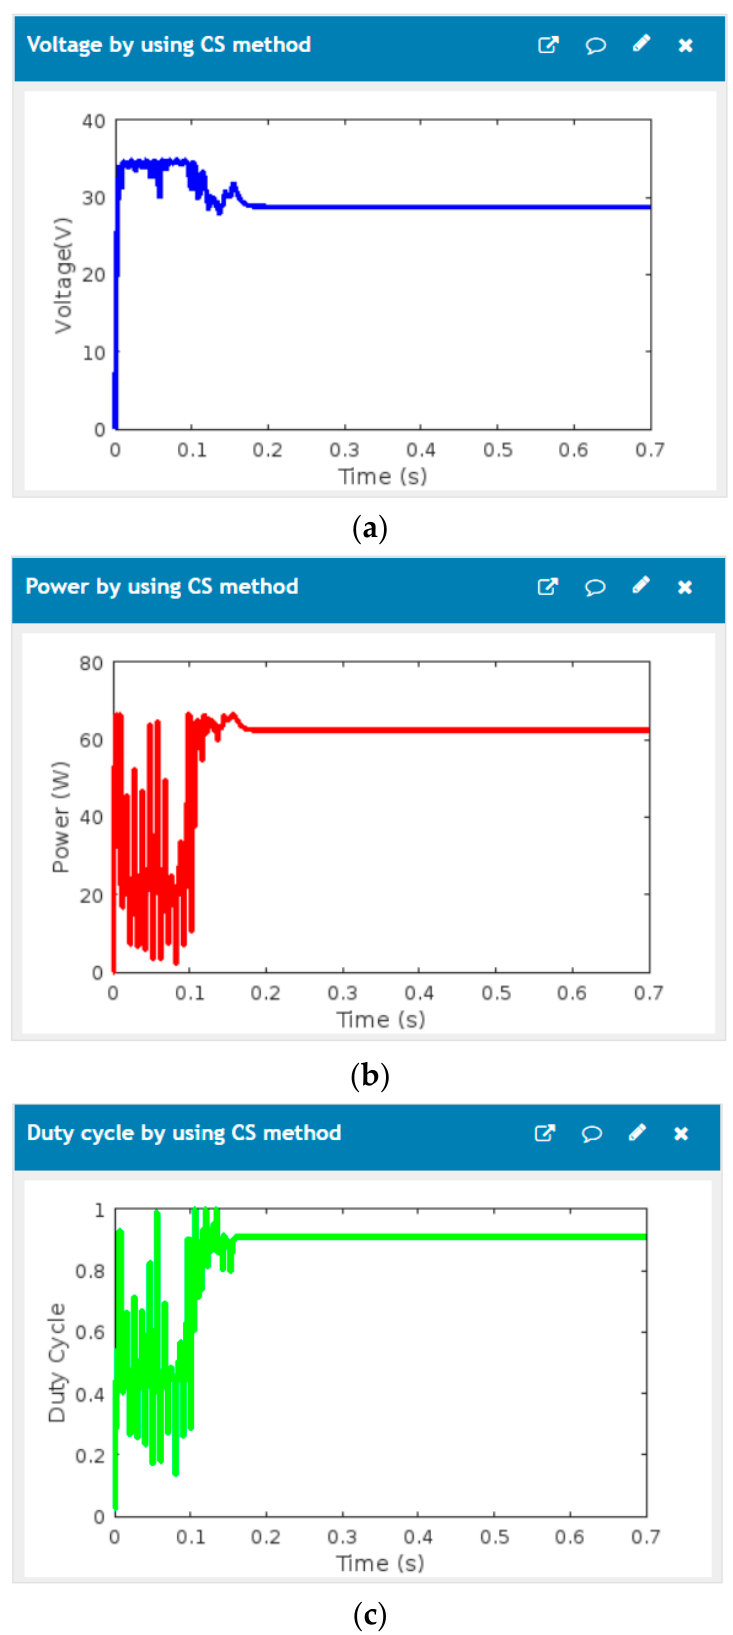
Figure 16. SCADA graphical user interface; ( a ) the voltage, ( b ) the power, and ( c ) the duty cycle using the cuckoo search method.